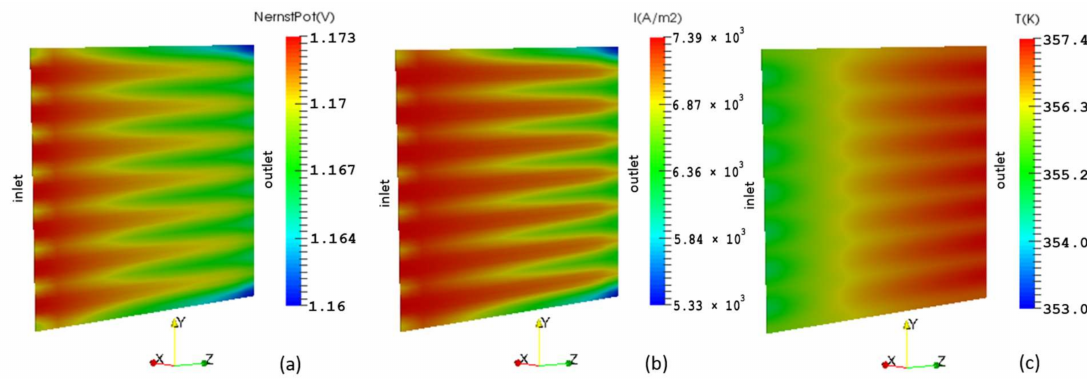
Figure 13. Membrane cathode interface showing the distribution of: ( a ) Nernst potential; ( b ) Local current density; ( c )